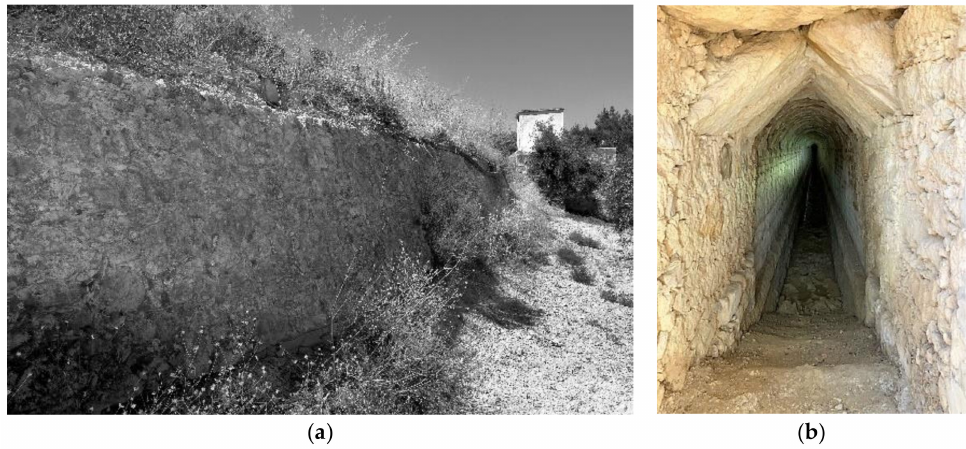
Figure 9. Fountana aqueduct: ( a ) remnant of it and ( b ) cross section of its tunnel (photos by A. N.